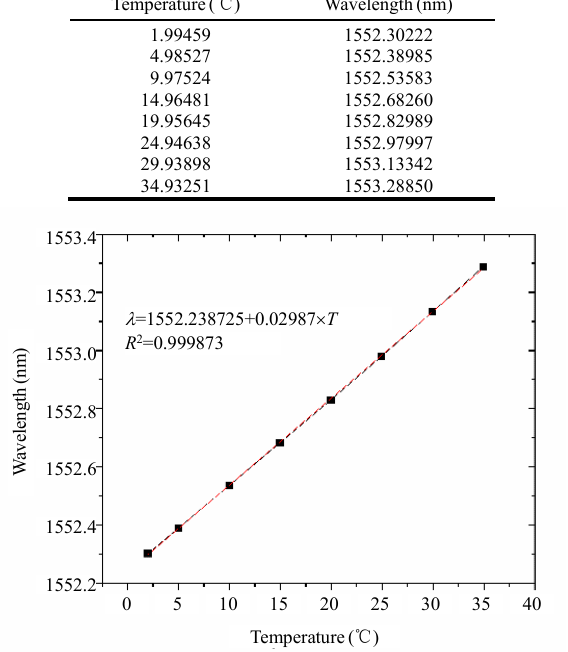
Fig. 5 Temperature calibration results for the FBG pressure sensor.